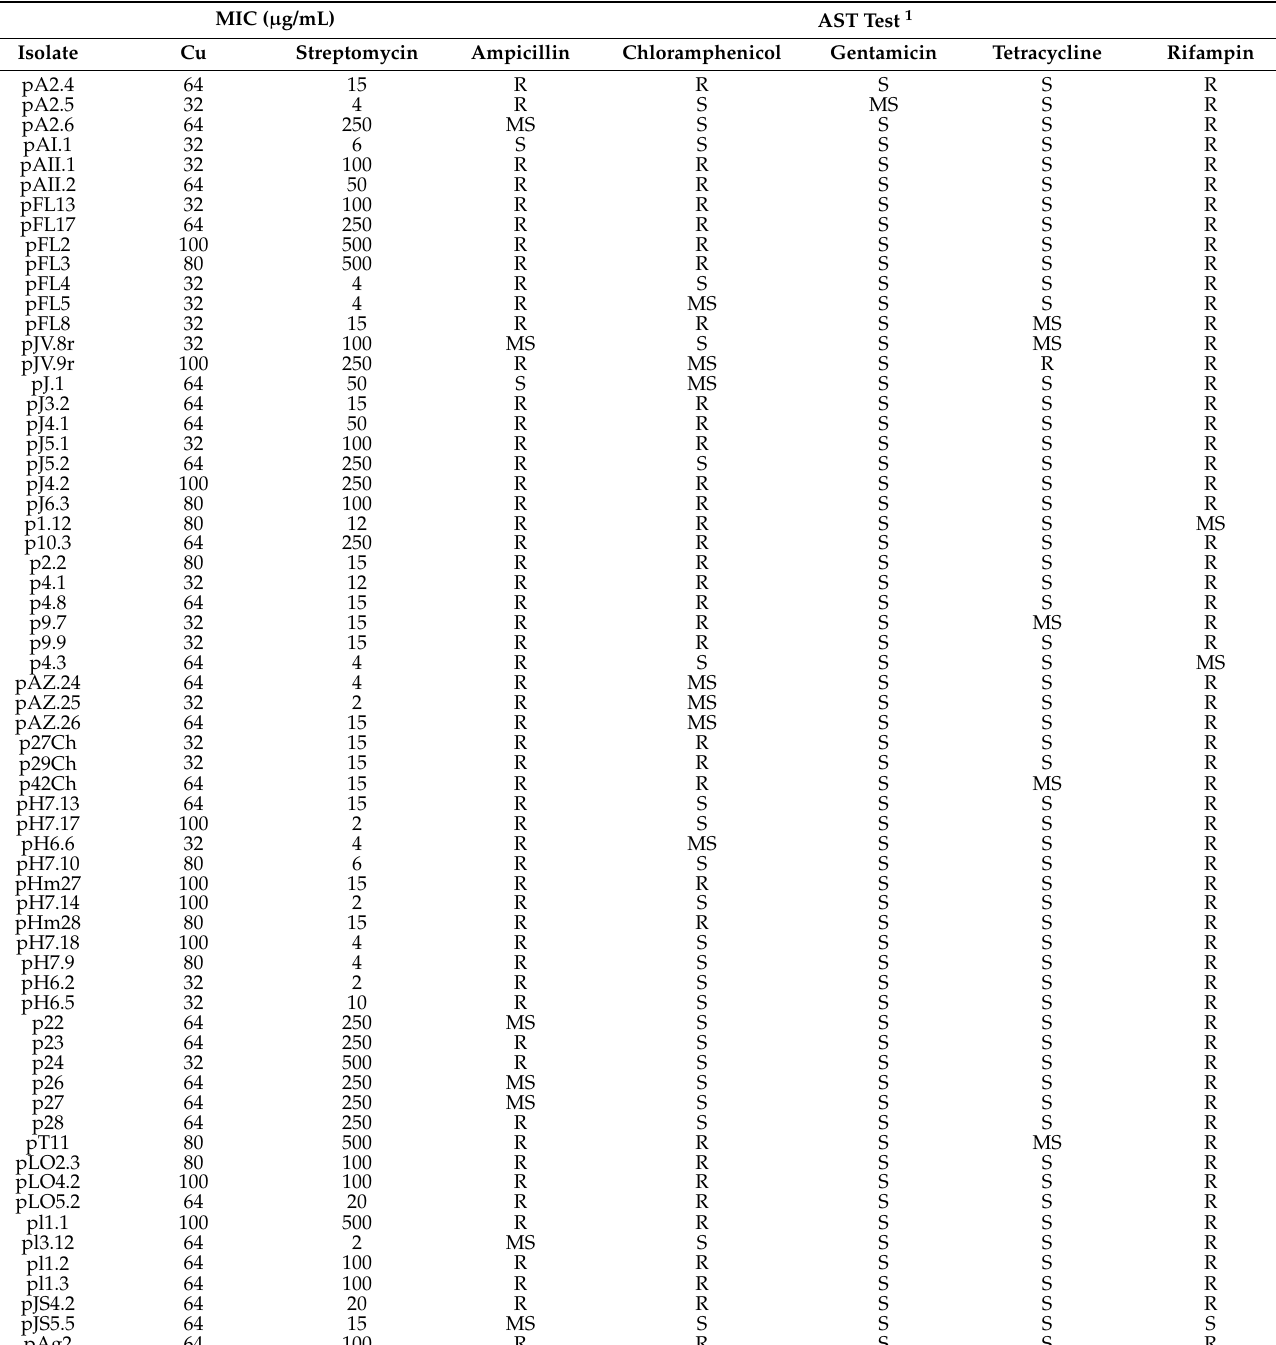
Table 5. Antimicrobial susceptibility of the Pseudomonas